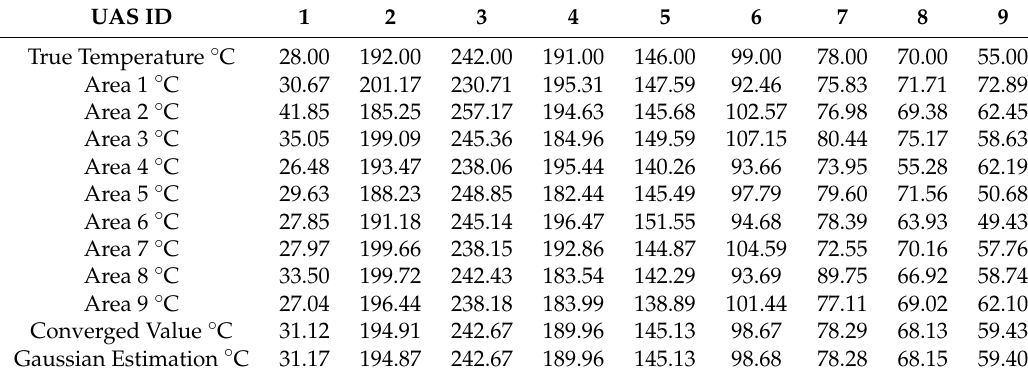
Table 3. Temperature measurements and estimations by agents across all areas of